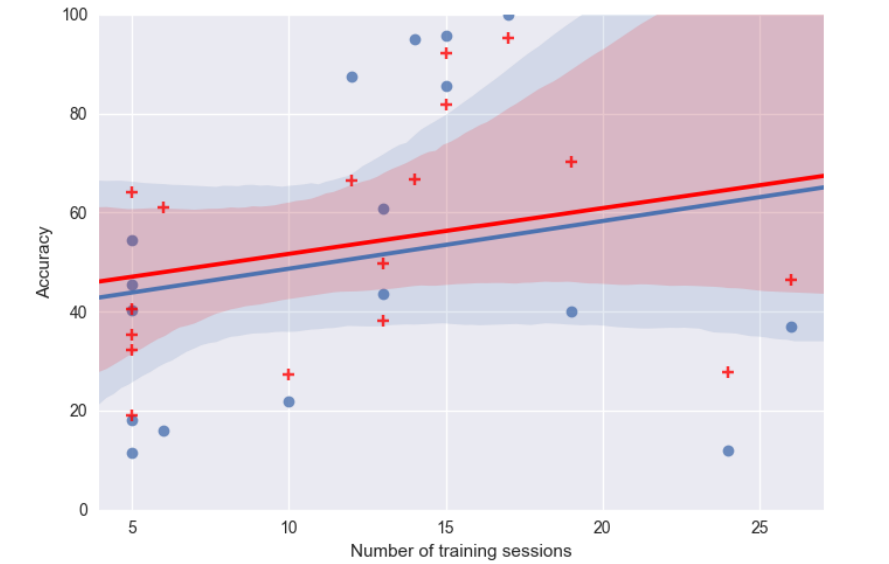
Figure 5. Relationship between the number of training sessions performed and the accuracy measures estimated (see accuracy definitions in Section 5.2). Blue points and the blue line are related to the notification accuracy and the red crosses and red line are related to the test